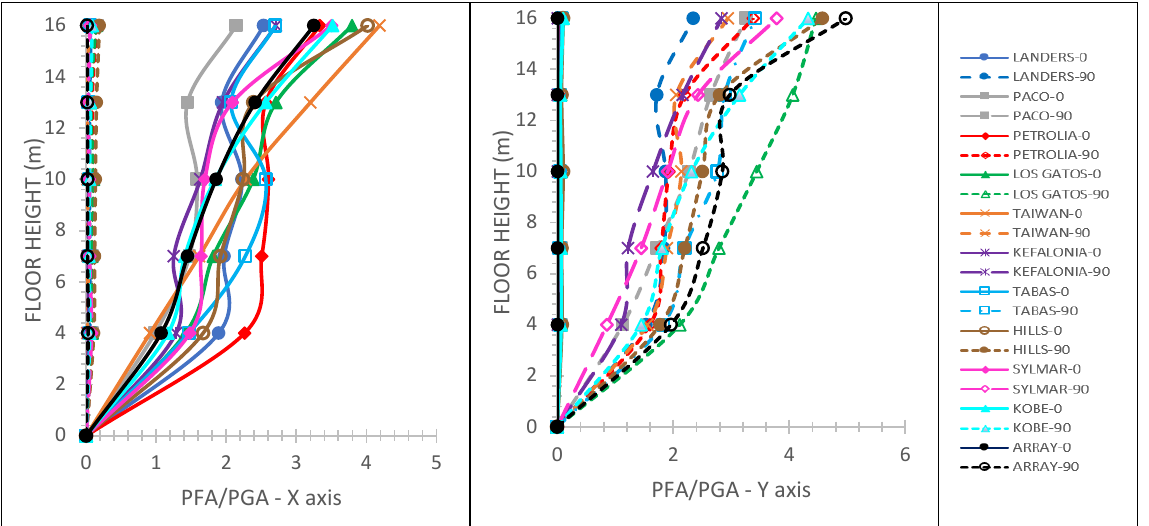
Figure 18. PFA/PGA along X ( left ) and Y ( right ) horizontal directions of the five-story mixed building, considering the fixed-pinned connection of the steel structure to the r/c one.